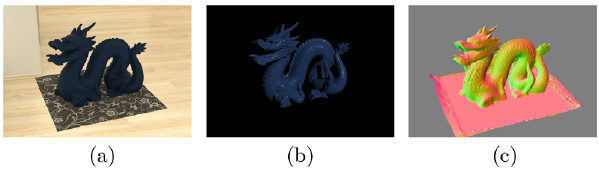
Fig. 8 Simulated example with blue-acrylic BRDF and Dragon geometry. (a) Example multi-view image with ambient lighting, for acquiring geometry. (b) Example single distant light image, for acquiring reflectance distribution. (c) Surface normal map acquired from multi-view